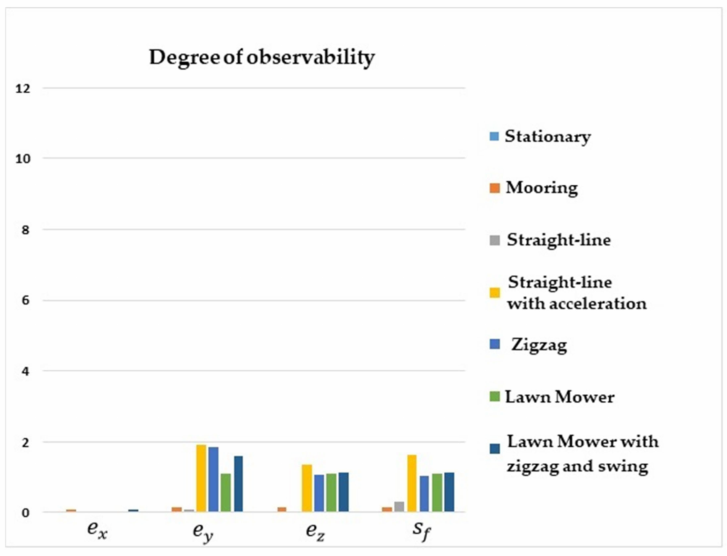
Figure 8. Degrees of observability of the IMU/DVL misalignment and the DVL scale factor error. INS/DVL/PS